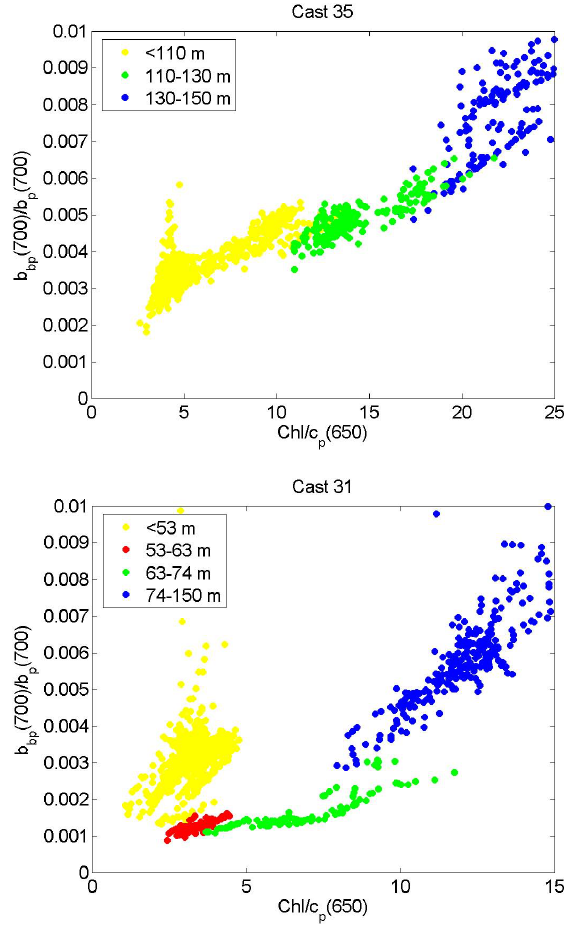
Fig. 12. Scatter plot of ˜ b bp versus [chl]/ c p for Casts 35 (top) and 31 (bottom). The data shown are not binned, and they are grouped (us- ing color coding) into four different depth intervals corresponding to distinct ecological